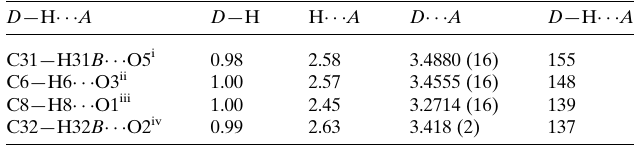
Table 5 Hydrogen-bond geometry (A˚ , (cid:4) ) for ( 2 ).